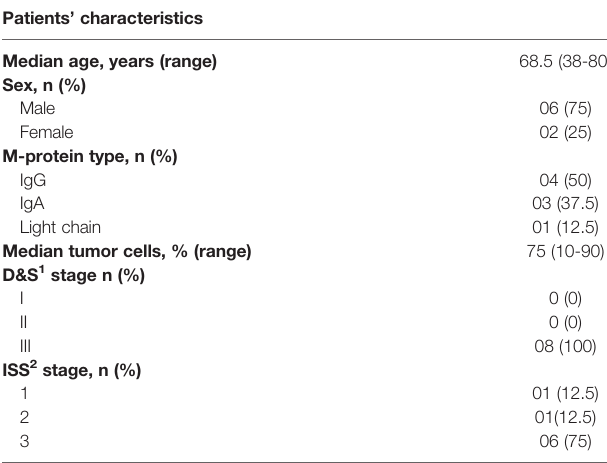
TABLE 1 | Clinical and laboratorial characteristics of MM patients included in the study at diagnosis (N = 8). Patients ’